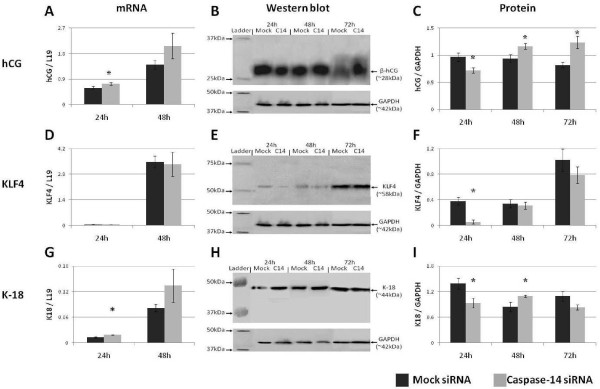
Caspase-14 modulates trophoblast gene expression during differentiation. The effect of caspase-14 siRNA on the expression of (A-C) hCG, (D-F) KLF4, and (G-I) cytokeratin-18 in Forskolin-treated BeWo cells. * = P < 0.05 versus Mock siRNA treated controls at the same time point.